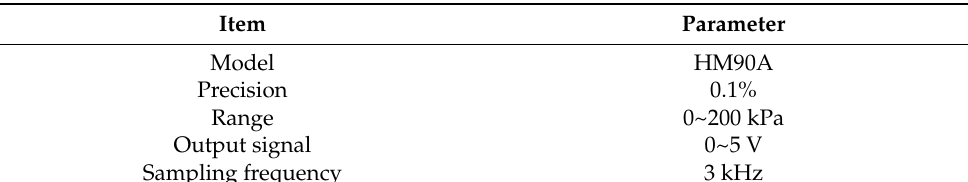
Table 2. The specific parameters of the pressure sensor used for the pressure field measurement in the pump.